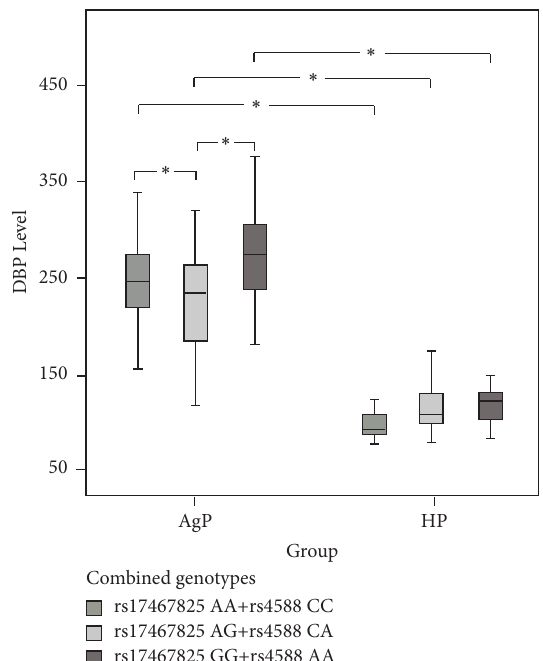
Figure2:PlasmaticDBPlevelcomparisonbetweenindividualswith different combined genotypes. AgP: aggressive periodontitis; HP: healthy participant; DBP: vitamin D-binding protein; ∗ 𝑝 < 0.05 : statistical